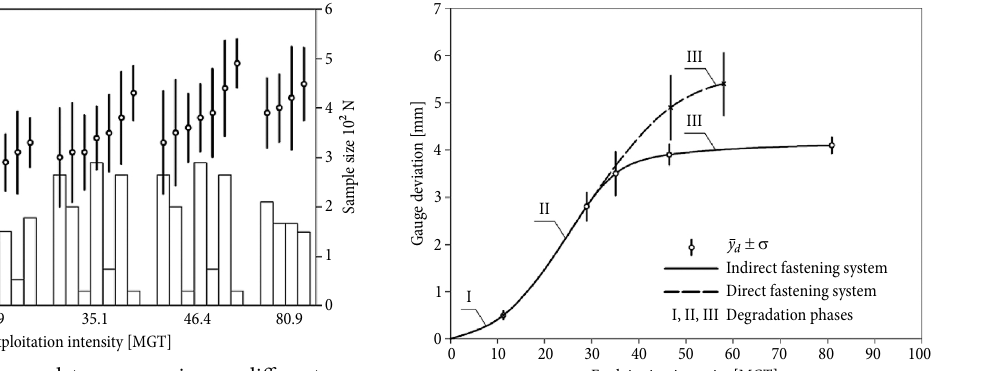
Fig. 4. Results of gauge data compression on different indirect elastic fastening system segments